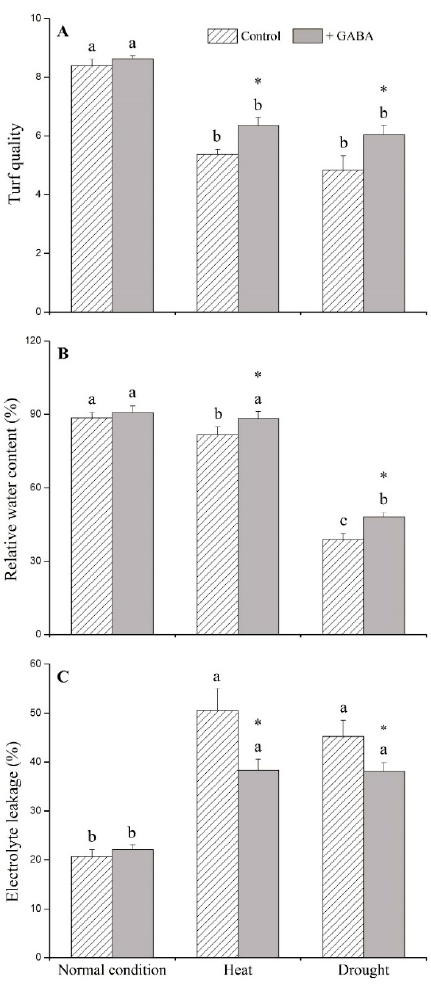
Figure 1. Effects of γ -aminobutyric acid (GABA) on ( A ) turf quality (TQ), ( B ) relative water content (RWC), and ( C ) electrolyte leakage (EL) in creeping bentgrass under normal, heat, and drought conditions. Vertical bars indicate ±standard error (SE) of mean ( n = 4). Different letters above columns indicate significant differences for one particular treatment (control or +GABA) under different conditions; asterisk “*” indicates significant difference between control and +GABA treatment under a given condition.